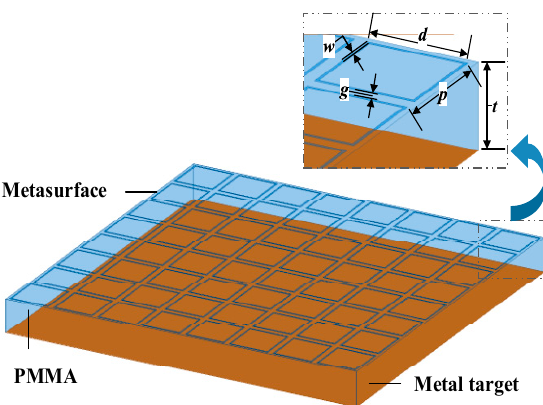
Figure 6. ( a ) The L - C relationship curves at 5.72 GHz and 18 GHz when d = 3.6 mm and ε r = 2.5; ( b ) the simulated absorption performances using ADS and HFSS under normally incident plane waves.